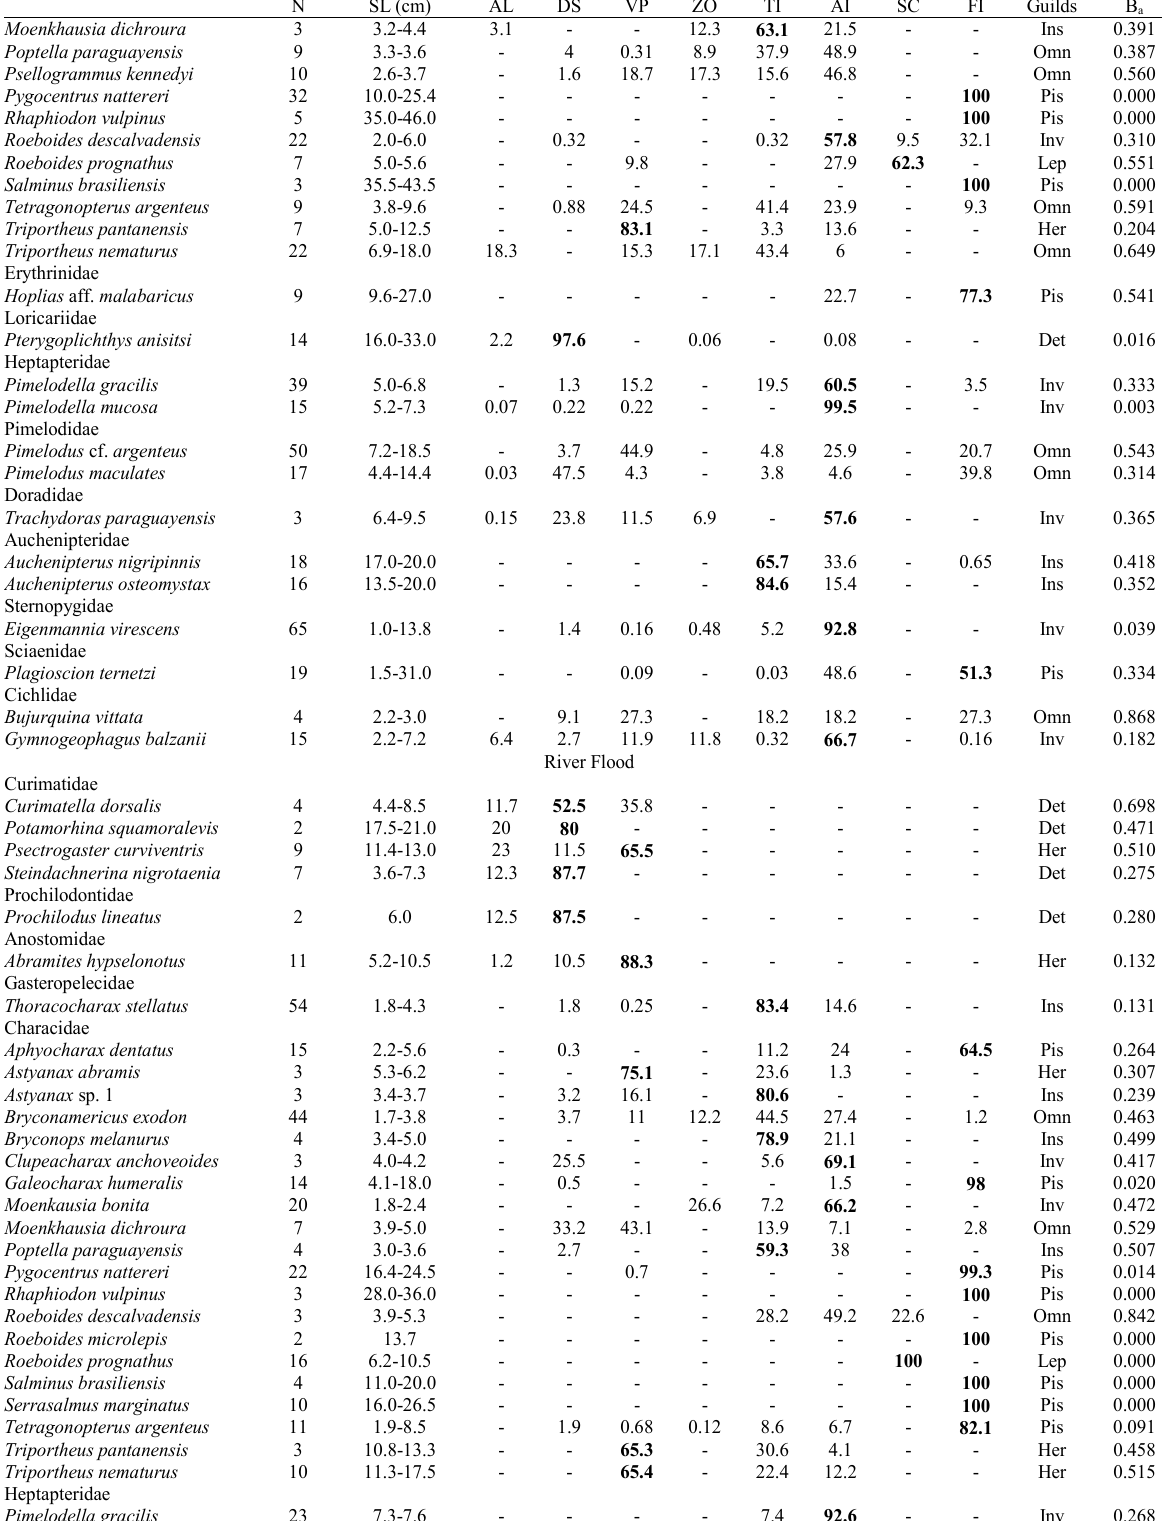
Table 1 (cont.). Diet composition (volume %) of the fish fauna in the seasonal Brazilian Pantanal, Cuiabá River basin, Mato Grosso State, Brazil. N = stomach contents analyzed. SL = standard length. AL = algae, DS = detritus/sediment, HP = vascular plant, ZO = zooplankton, TI = terrestrial insects, AI = aquatic invertebrates. SC = scales, FI = fish. Number in bold indicate the main food resource (V > 51%). B = standardized trophic niche a